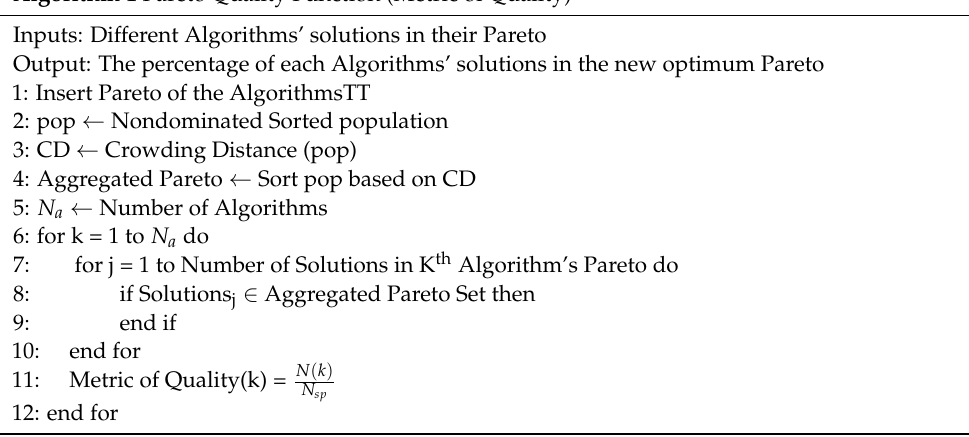
Algorithm 1 Pareto Quality Function (Metric of Quality)